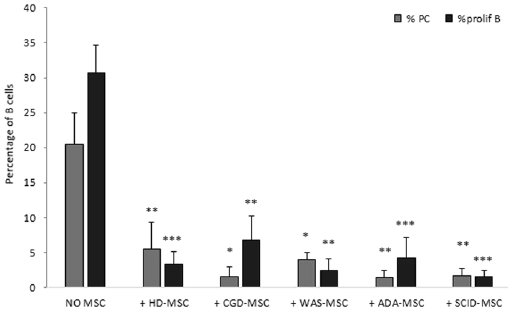
Figure 3. In vitro immunomodulatory effect of HD- and PID-MSCs on B-cell proliferation and plasma-cell (PC) differentiation in an allogeneic setting. PBMCs were stimulated with CpG for 7 days and co-cultured with or without MSCs. Cells were collected, stained for CMFDA, CD19, CD27, CD38 and IgM and analyzed by flow-cytometry. The graph shows the percentage of proliferating B cells and plasma-cells stimulated with CpG either in the absence (NO MSC) or in the presence of HD-, CGD-, WAS-, ADA- and SCID-MSCs ( + HD-MSC, + CGD-MSC, + WAS-MSC, + ADA-MSCs, + SCID-MSC) (MSC:PBMC ratio 1:10). Each bar represents the mean ± SEM of multiple experiments (9 HD-MSCs, 5 CGD-MSCs, 9 WAS-MSCs, 4 ADA-MSCs and 4 SCID- MSCs were tested at least twice and each point being in triplicate). P values lower than 0.05 were considered to be statistically significant ( * p < 0.05; ** p < 0.01; *** p <